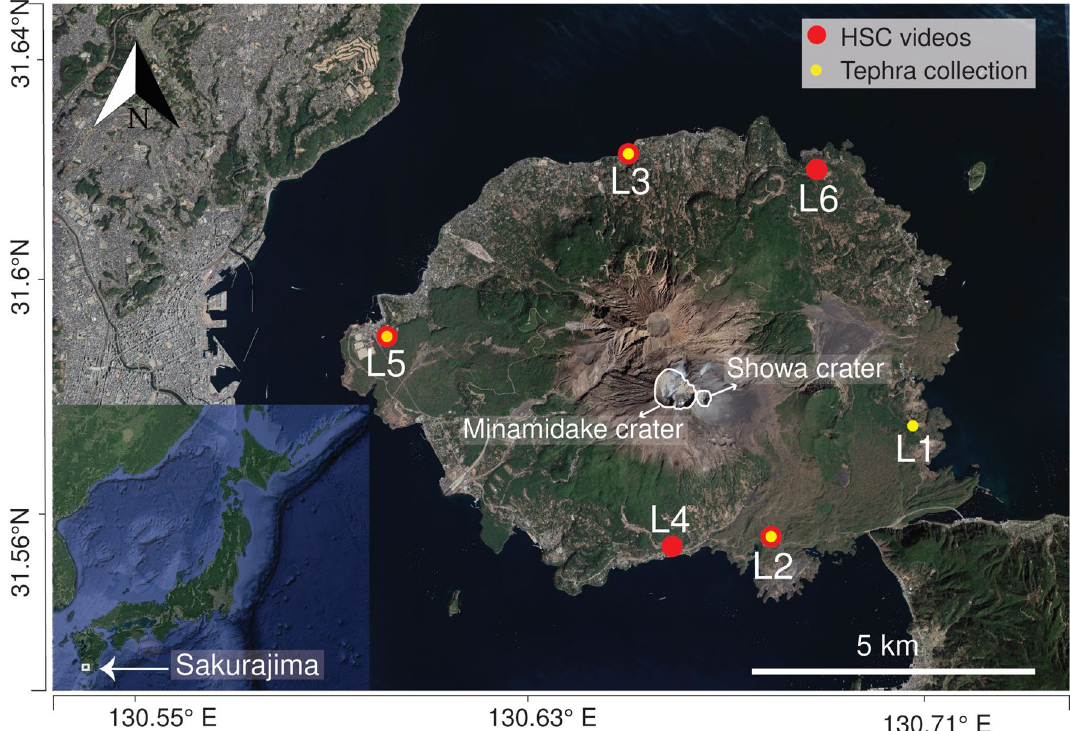
Figure 1. Location of the study area. The circles correspond to individual locations; L1 corresponds to location used on November 15, L2 was used on November 16, L3 was used on November 17, L4 was used on November 20, L5 was used on November 23 and L6 was used on November 20 (see Table 1 for more details). Large red circles represent the locations of the HSC videos and small yellow circles represent the location of tephra collection. Image taken from Google Earth (03/03/2017). Image © 2021 Maxar Technologies